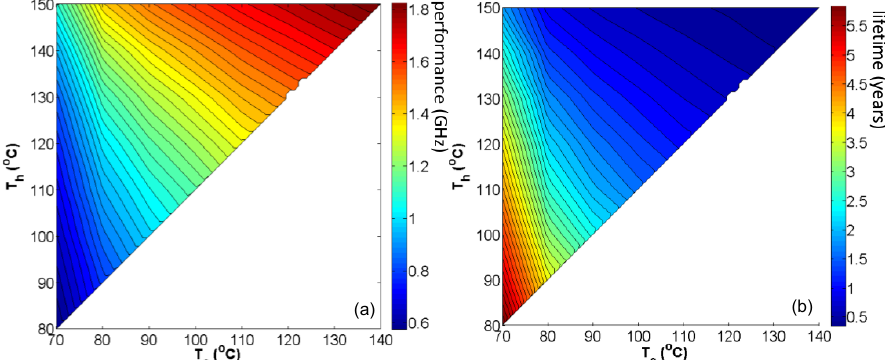
Figure 12. DTM constraints’ exploration: ( a ) performance; ( b )